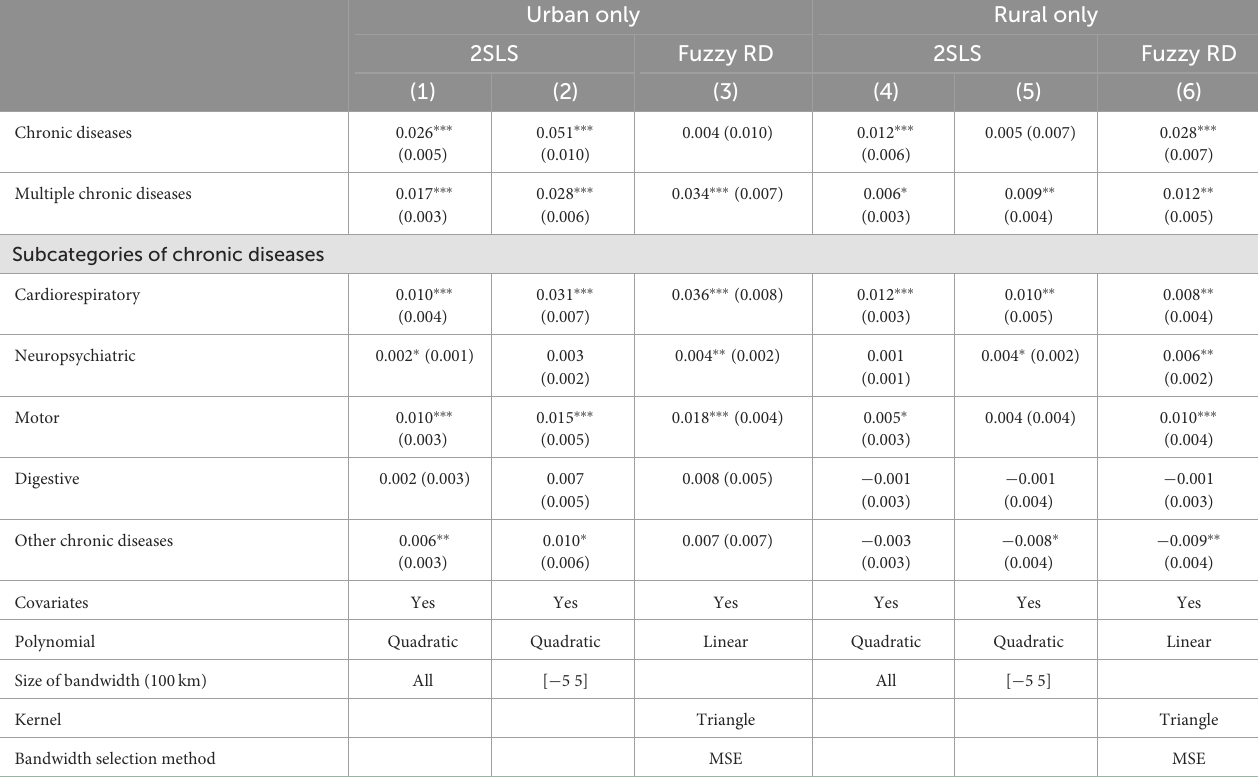
TABLE 9 Heterogeneous effect of the Huai river policy on chronic diseases by urban/rural